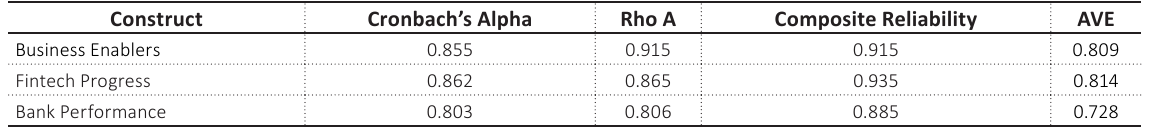
Table 1. Reliability and validity